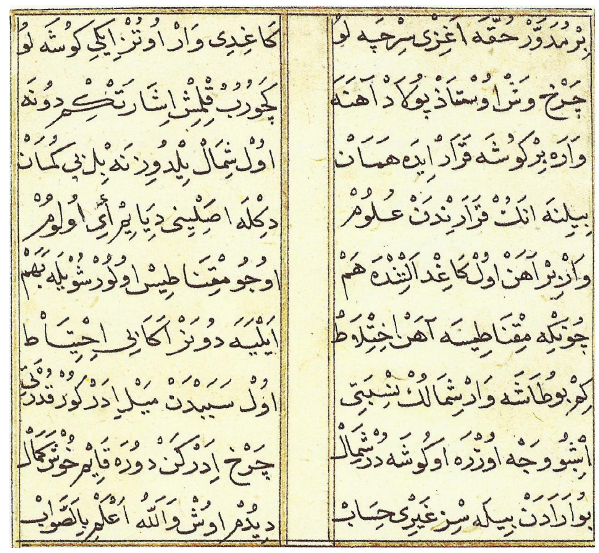
Figure 2a. A poem about the compass in Kitab-ıBahriye .